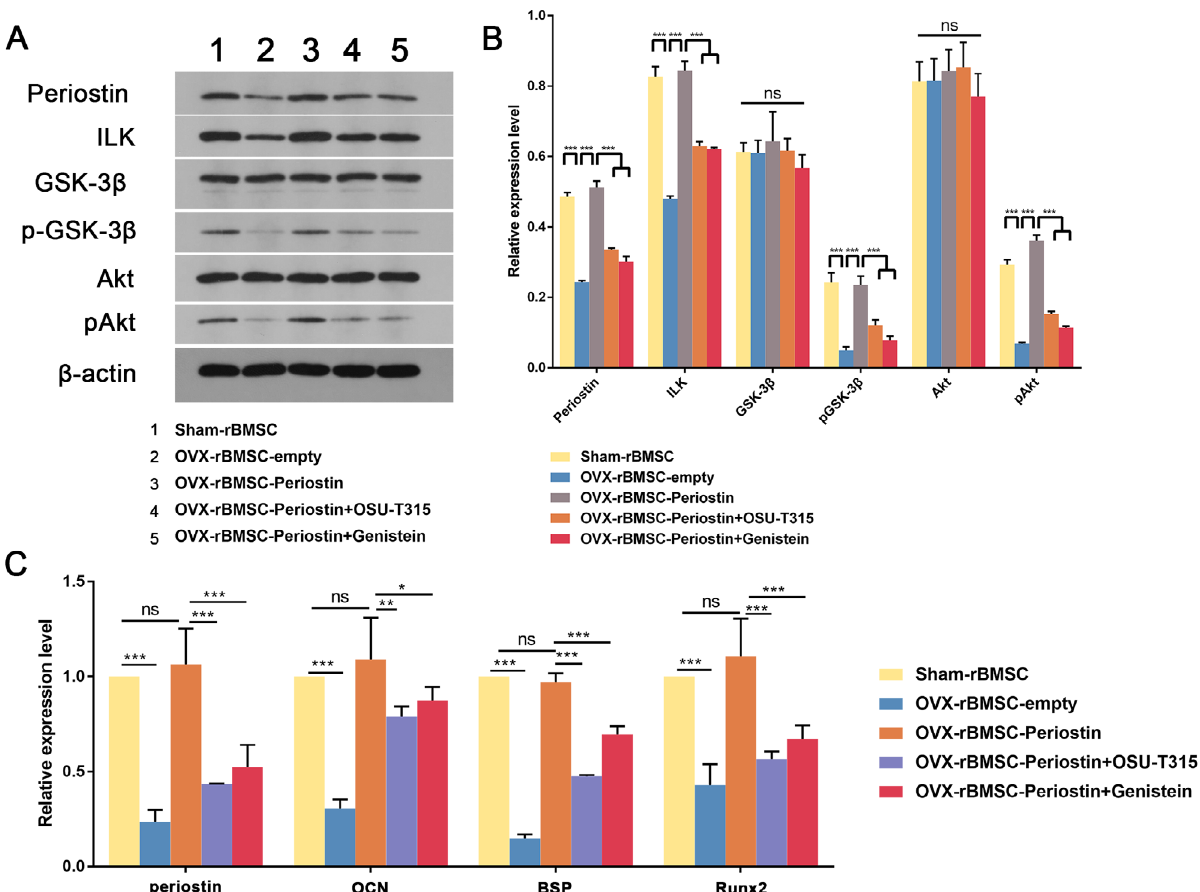
Figure 7 ‒ Periostin regulates the expression of ILK, pAkt and GSK3β in OVX-BMSCs. (A) The expression levels of periostin, ILK, GSK3β, pGSK3β, Akt, pAkt in the indicated groups on day 7 after osteogenesis induction were examined by western blotting; β-actin served as the reference gene. (B) Quantitation of western blotting in (A) was performed using Image J software. (C) Graphs showing the relative mRNA expression levels of periostin, OCN, BSP and Runx2 in the indicated groups on day 7 after osteogenesis induction. Data are presented as the mean ± SD of 3 independent experiments.